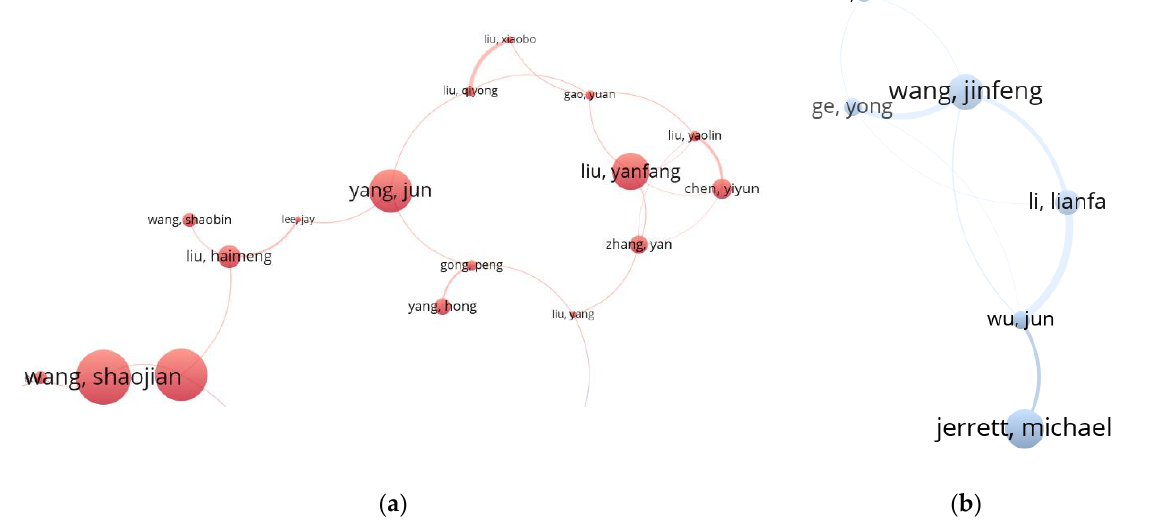
Figure 7. Two research communities in China: ( a ) Wang–Yang–Liu community (Wang, 31.74; Yang, 24.88; Liu, 21.61); and ( b ) Wang community (Wang, 12.12). (Note: ( b ) is zoomed in to fit the